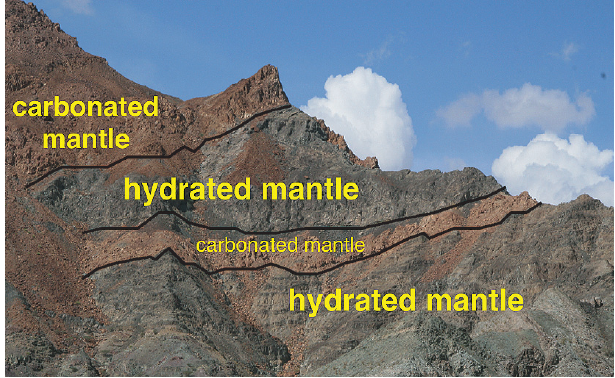
Figure 6. Fully carbonated lenses (magnesite + quartz + chromian spinel) within partially serpentinized mantle peridotite, near the base of the Samail mantle section where peridotites were thrust over metasediments. The lenses are parallel to the basal thrust. The thinner lower lens is about 10 m thick; the thicker upper lens is about 200 m thick. Together, they contain about one billion tons of CO 2 in solid carbonate minerals.